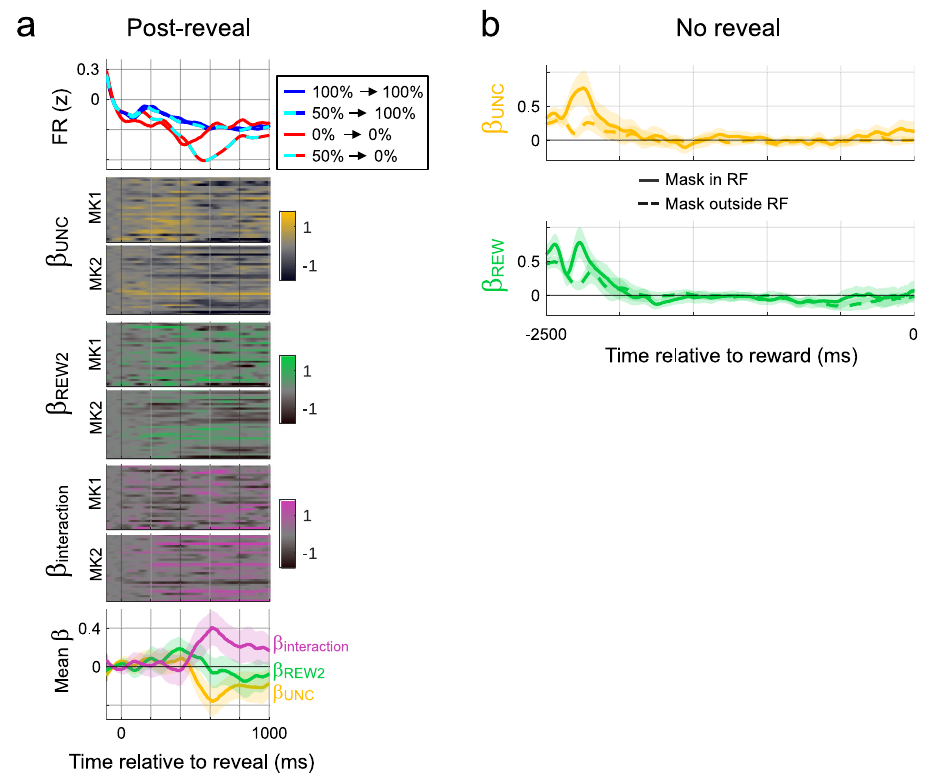
Fig. 6 | LIP neurons responded to new visual information. a Responses to the information conveyed by Cue 2. Top: Firing rates on trials in which Cue 2 was revealed,aligned on the time of reveal. PSTHs showaverage fi ring for the possible combinations of reward and uncertainty resolved by Cue 2 ( n =60 cells with at least 2 trials in each condition). Pre-reveal fi ring was subtracted to remove effects of Cue 1. Heatmaps show time-resolved regression coef fi cients (uncertainty,